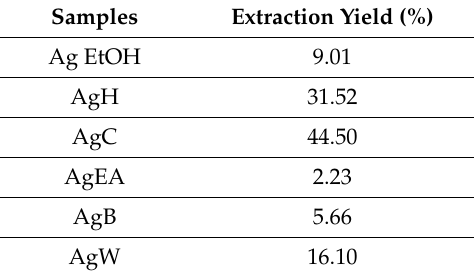
Table 1. Extraction yields of Azorella glabra ethanol extract and its